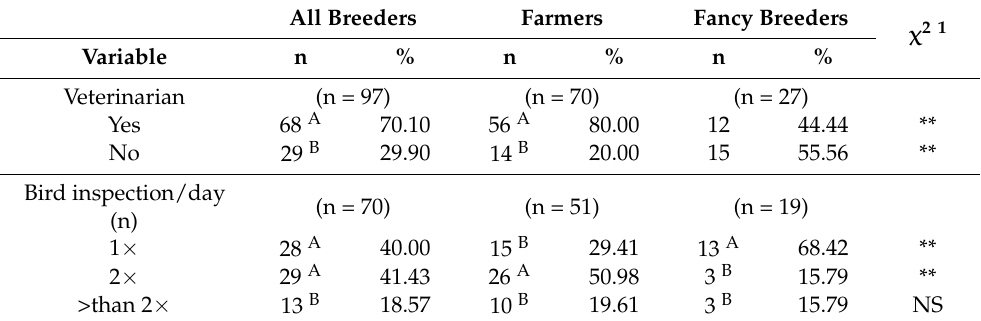
Table 11. Flock health management: responses from all breeders and divided according to breeder category. All